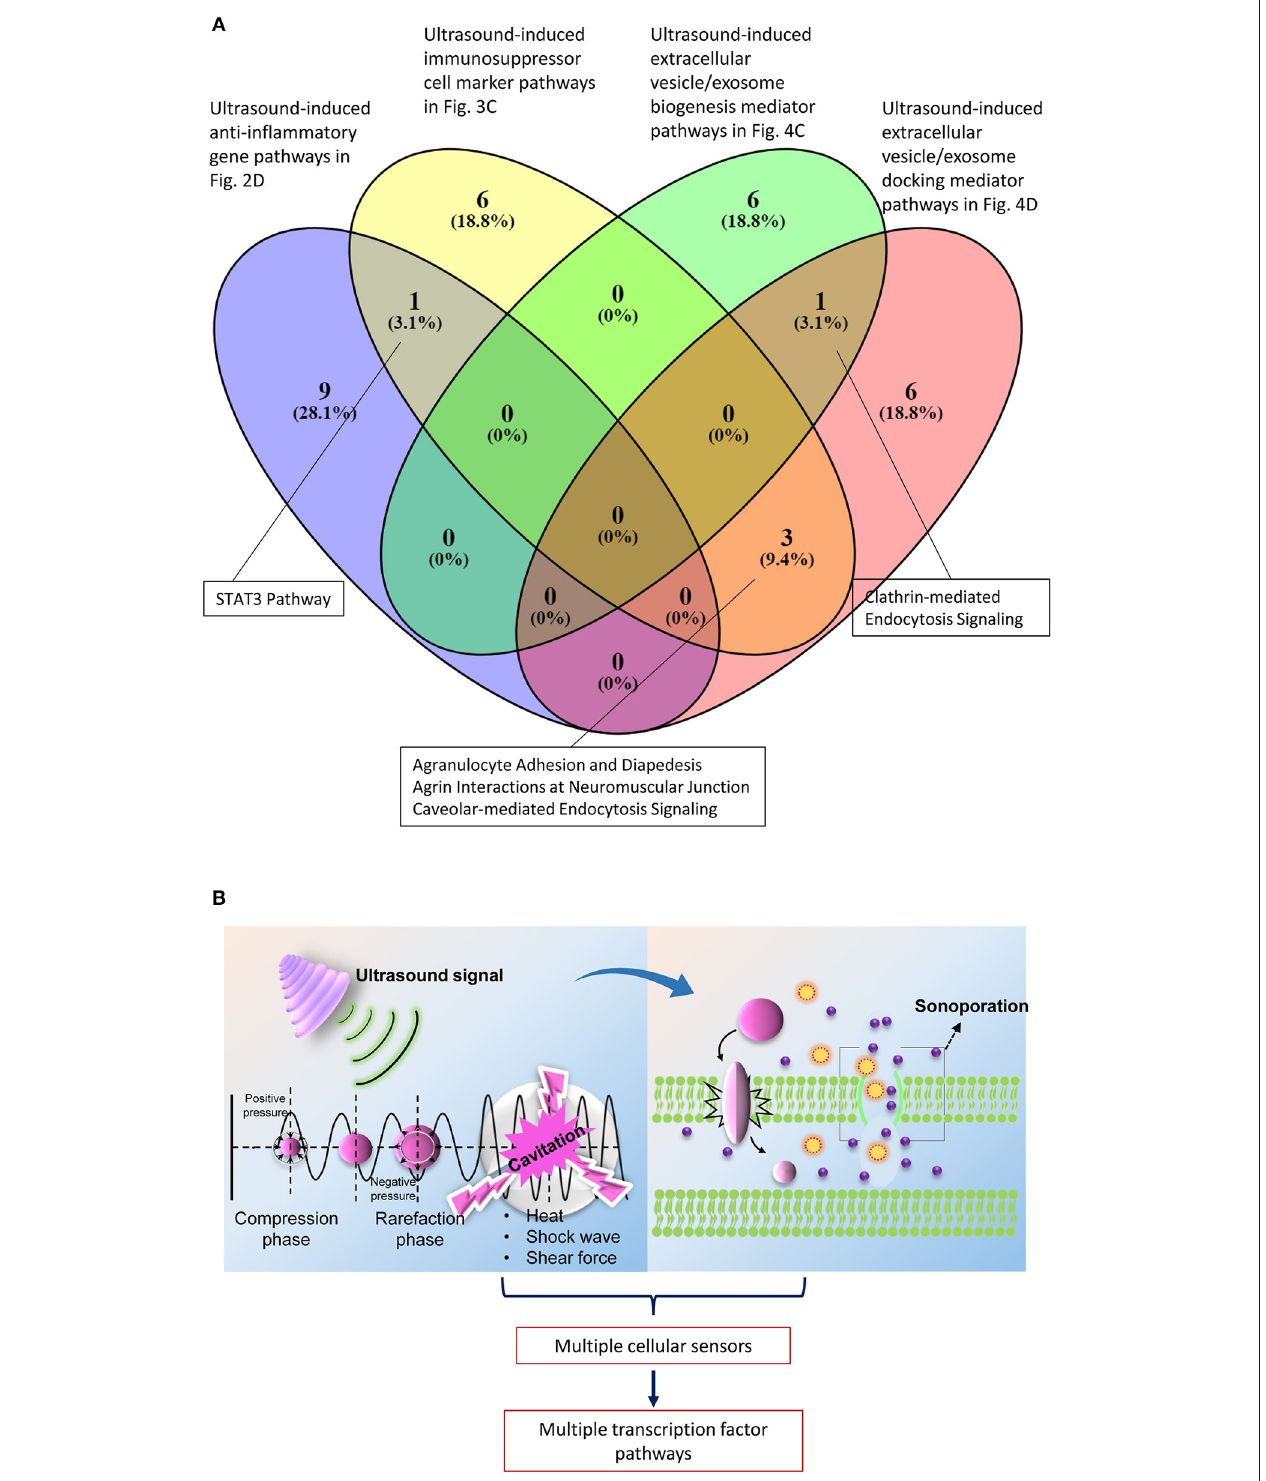
FIGURE 6 | Most of the signaling pathways that are regulated by the mechanisms that are activated by LIUS are not shared. (A) Venn analysis revealed that STAT3 signaling pathway is shared between the anti-inflammatory genes and immunosuppressive regulator genes that are upregulated by LIUS therapy. Likewise, clathrin mediated endocytosis signaling is shared by genes that enhance exosome biogenesis and docking with ultrasound therapy and 3 signaling pathways are shared by immunosuppressor regulator genes and exosome docking genes. (B) The physical properties exerted by ultrasound therapy may activate multiple cellular sensors that activate distinct transcription factors to regulate various signaling